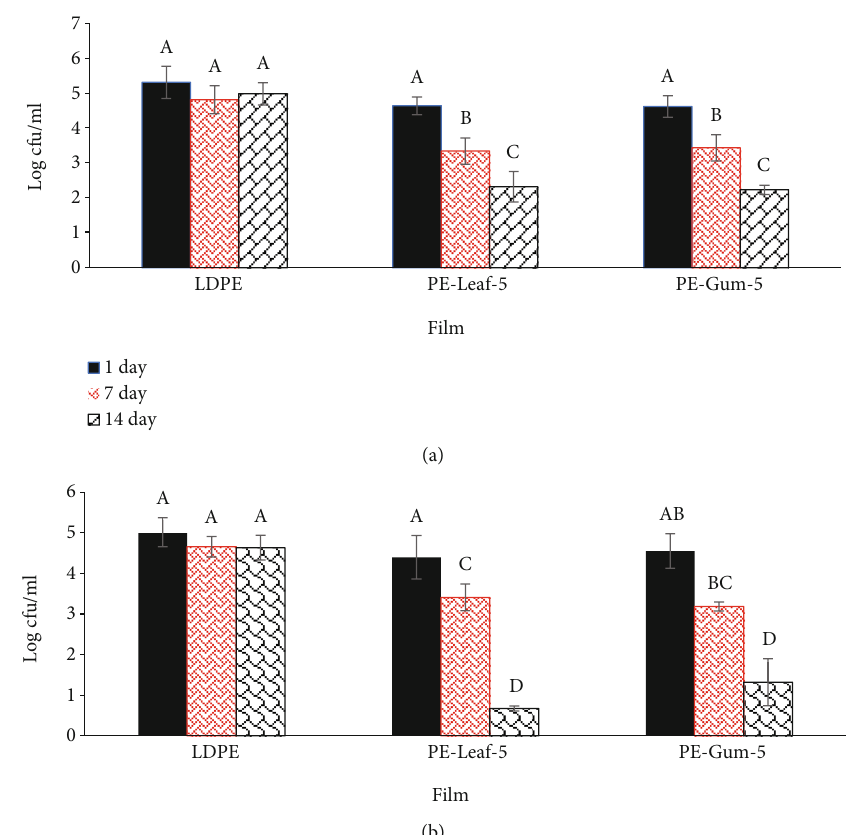
Table 6: Thermal properties (starting, peak, and end points ( ° C)) and enthalpy (mJ/mg) of leaf and gum extracts and fi lms containing them. Sample Concentration (%) Gum extract Polyethylene fi lm PE-Leaf